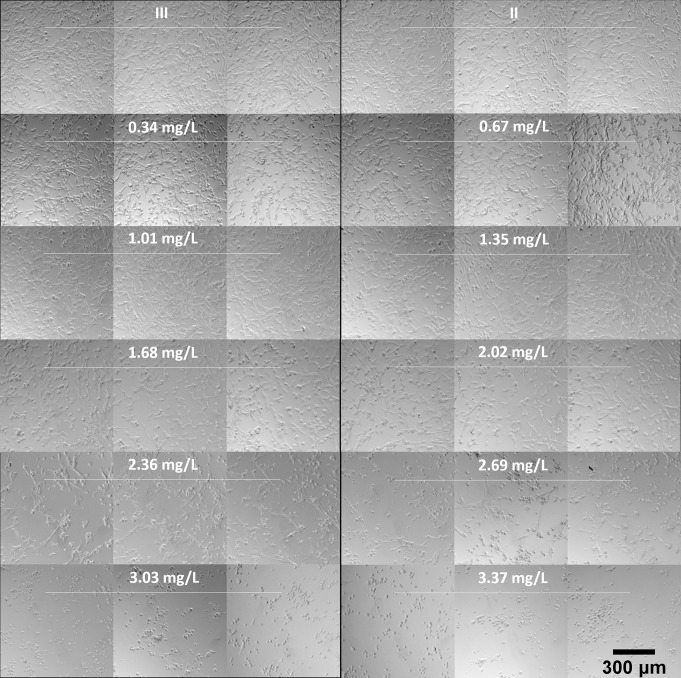
Representative images of the visual appearance of cultured porcine fibroblast cells exposed to electrically generated silver ions.3.37 mg/L of silver ions were generated by 380 nA of direct current from pure silver electrodes. A series of 10% dilution of silver ion medium was prepared and immediately transfer to fibroblast cells for 21 hours of incubation. Chamber II (the cathode) and III (no current) are controls (no silver ions).